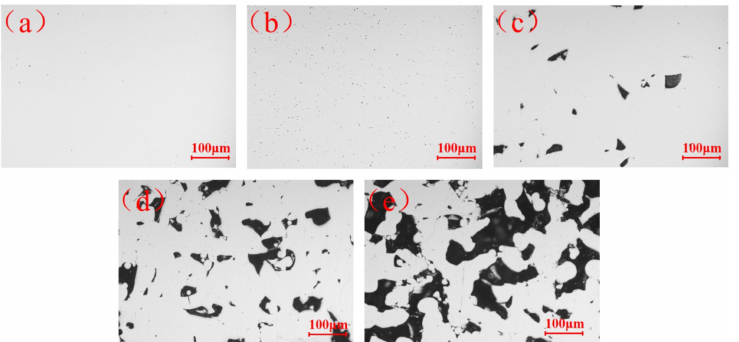
Figure 4. Optical microscope images of samples at different energy densities: ( a ) E v = 138.0 J/mm 3 and E d = 108.4 J/mm 3 ; ( b ) E v = 46.3 J/mm 3 and E d = 62.5 J/mm 3 ; ( c ) E v = 41.7 J/mm 3 and E d = 49.7 J/mm 3 ; ( d ) E v = 33.3 J/mm 3 and E d = 47.5 J/mm 3 ; ( e ) E v = 25.0 J/mm 3 and E d = 35.6 J/mm 3 .